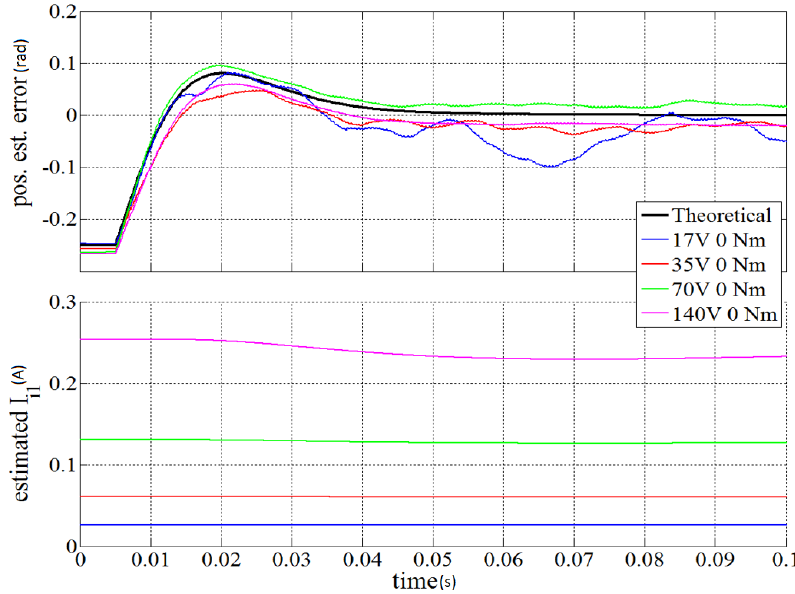
Figure 10. Step response of position tracking loop (motor #2).